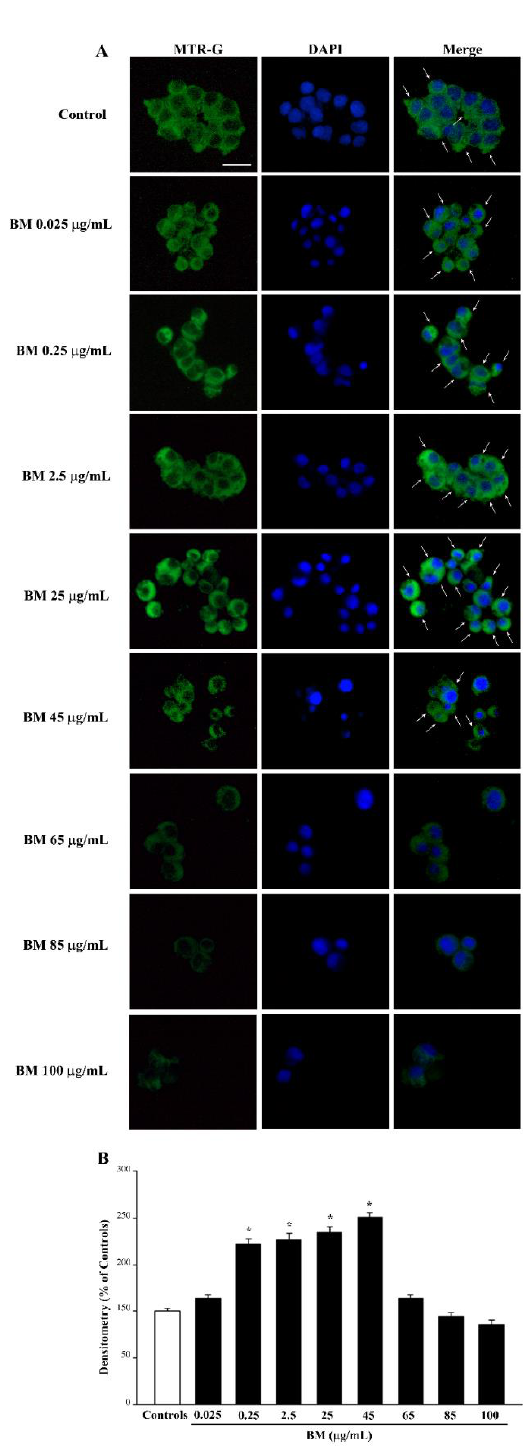
Figure 9. MitoTracker Green (MTR-G) fluorescence after increasing doses of BM. ( A ) Representative pictures show that MTR-G fluorescence, which labels total (both healthy and not healthy) mitochon- dria, is increased by low doses of BM (from 0.025 µ g/mL to 45 µ g/mL), while it is reduced by the highest doses of BM used in the present work (from 65 µ g/mL to 100 µ g/mL). Arrows indicate intensely MTR-G-stained cells. Cell nuclei are stained in blue with DAPI. ( B ) The graph reports the densitometry of MTR-G fluorescence. Values are given as mean percentage ± S.E.M. of optical density (assuming controls as 100%) from three independent experiments. * p < 0.05 compared with controls. Scale bar = 17 µ